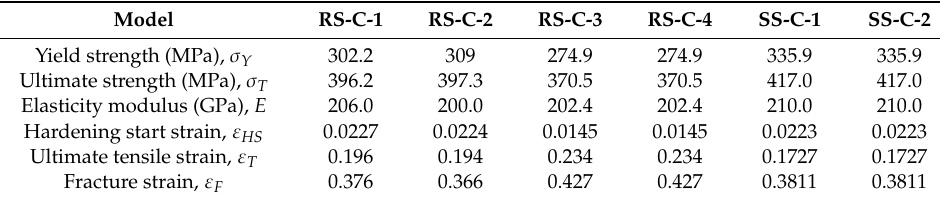
Table 2. Material properties of test models.